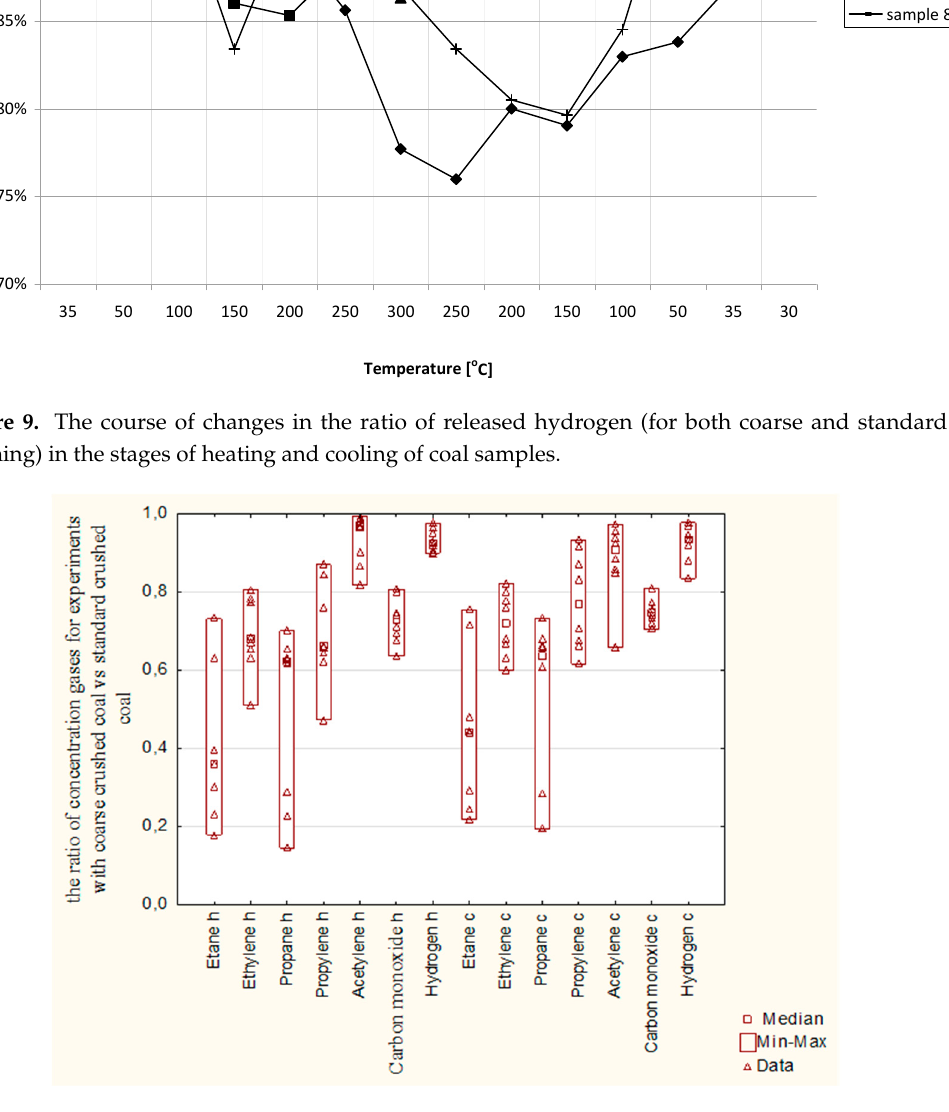
Figure 10. Distribution of average differences between standard and coarsely crushed coal for the heating (h) and cooling (c) phase. heating (h) and cooling (c)